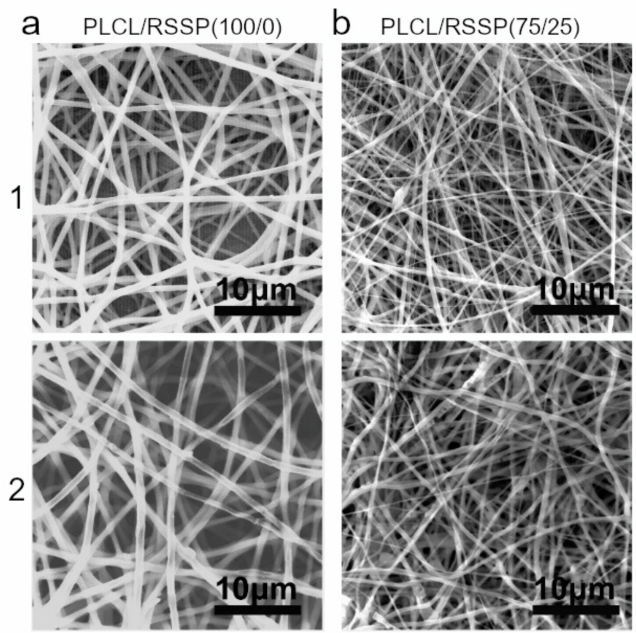
Figure 8. SEM images of degraded membranes. ( a1 ) PLCL/RSSP (100/0) membranes before degrada- tion; ( a2 ) PLCL/RSSP (100/0) membranes after 4-week degradation; ( b1 ) PLCL/RSSP (75/25) before degradation; ( b2 ) PLCL/RSSP (75/25) membranes after 4-week